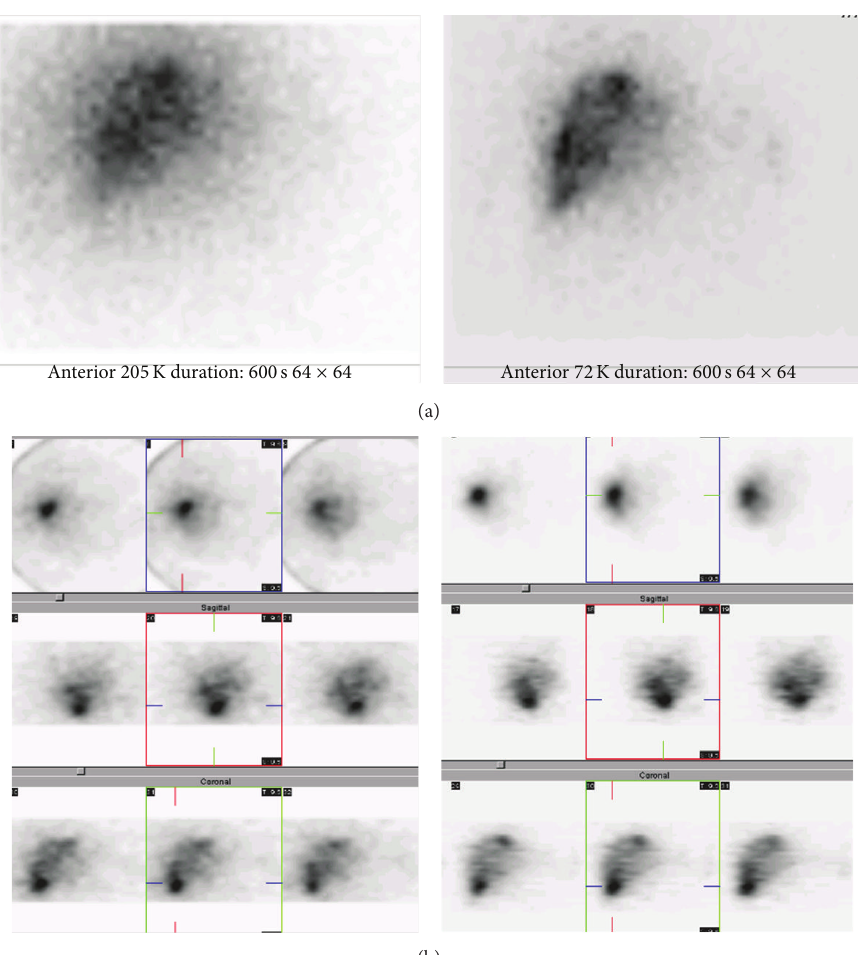
Figure 2: A patient with metastatic colon cancer treated with 333 MBq 32 P particles. (a) Bremsstrahlung 32 P images in planar study with LEHR and MEGP collimators. (b) Bremsstrahlung 32 P images in SPECT study with LEHR and MEGP collimators.